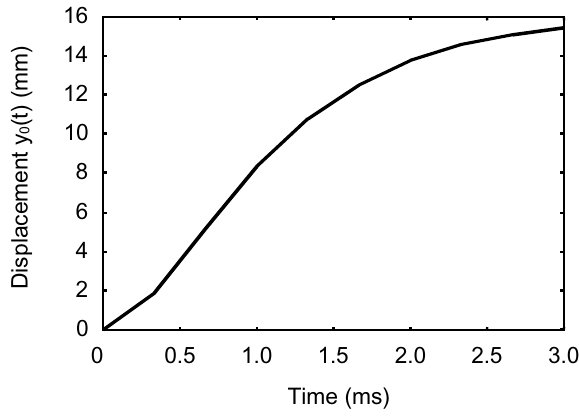
Fig. 7. Plate displacement in the absence of isolator and human body.